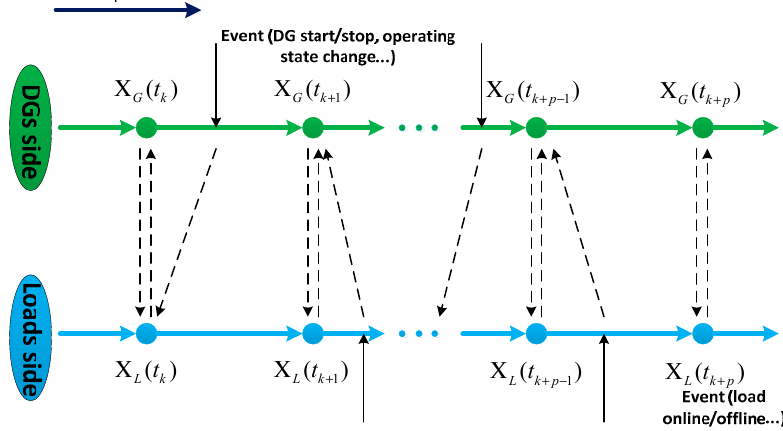
Figure 4. Combination of time-driven and event-driven state transition mechanisms.